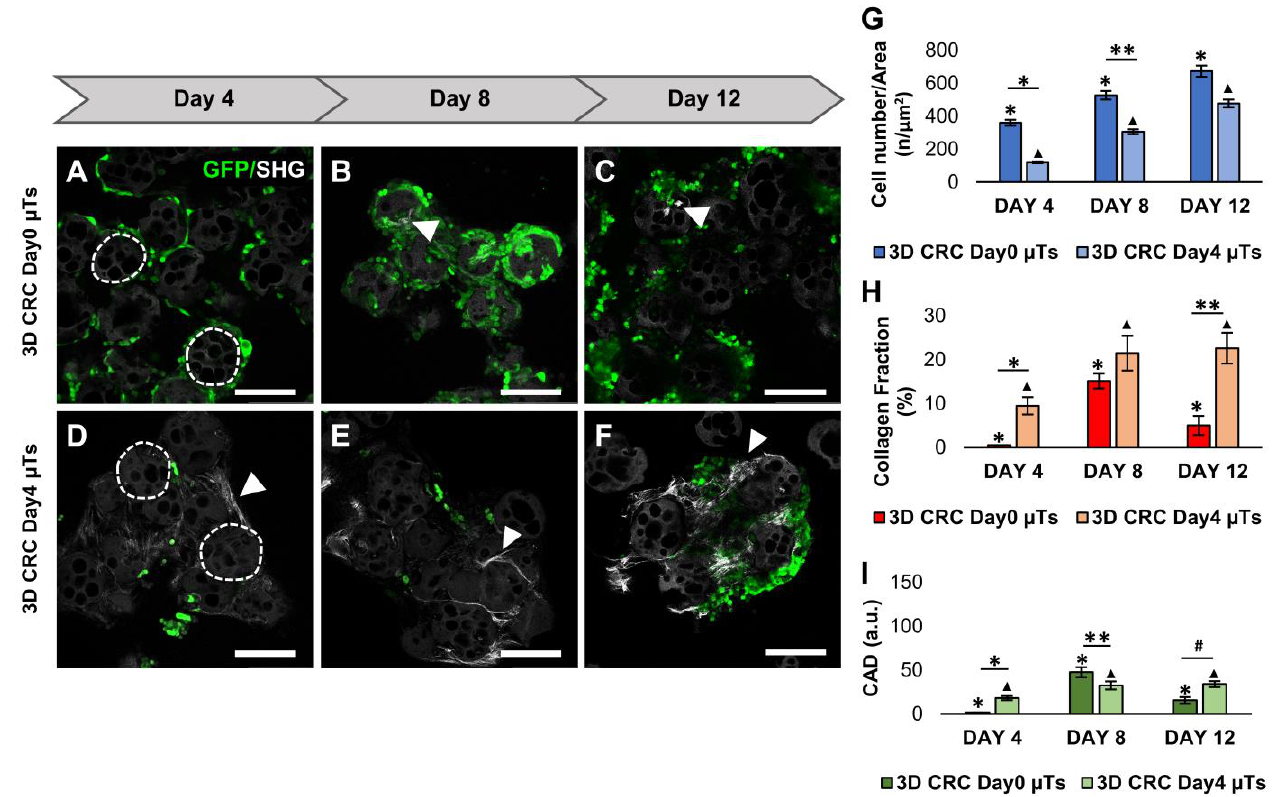
Figure 2. Comparison of cancer cell counts and extracellular matrix (ECM) remodeling between the 3D CRC Day0 µTs and 3D CRC Day4 µTs monitored on days 4, 8, and 12 of culturing. ( A – C ) Confocal images of 3D CRC Day0 µTs; ( D – F ) confocal images of 3D CRC Day4 µTs; scale bar: 150 µm. Gelatin microbeads are indicated by the dotted lines, green fluorescent protein (GFP) expressed by HCT-116 cells (green), and collagen Second Harmonic Generation (SHG) signal (white arrows). ( G ) Graph of cell numbers over time for the HCT-116 cells in the microtissues; ( H ) collagen fraction analysis; ( I ) collagen assembly degree (CAD) analysis. All the experiments were performed in triplicate (n = 3), and values represent the mean and the mean standard error ( ∗; ∗∗; ; # p < 0.05).